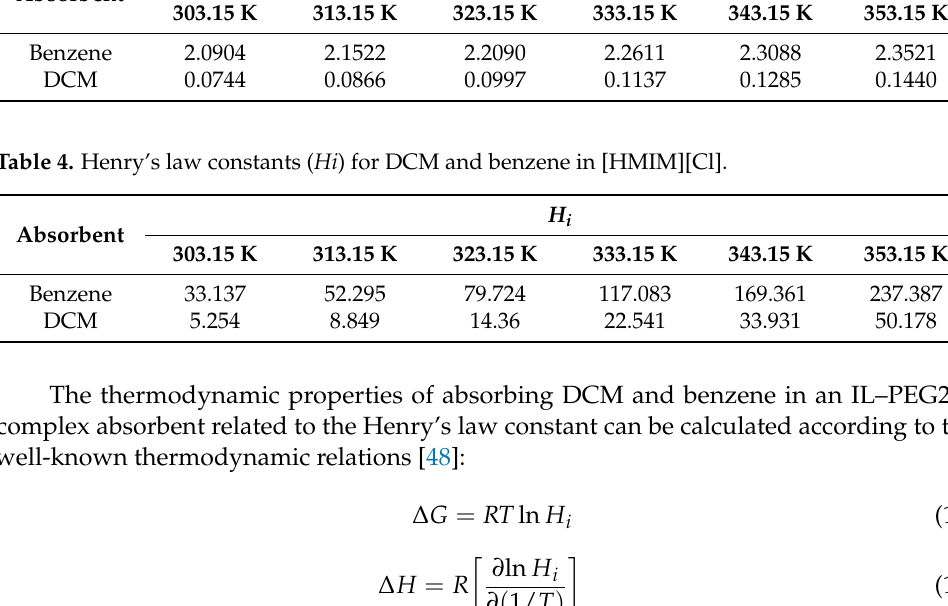
Table 3. Infinite dilution activity coefficients ( γ ∞ ) for DCM and benzene in [HMIM][Cl]. Absorbent